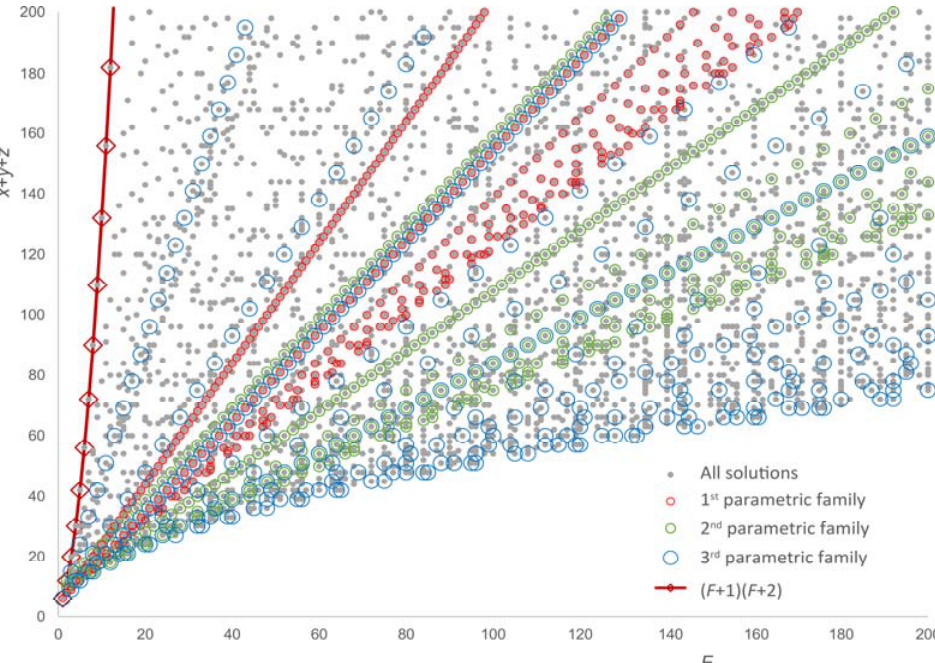
Figure 2. Sum of solution terms of the Diophantine equation xyz = F ( x + y + z ). An upper bound and sums of terms for parametric solutions are indicated by red line and open circles, respectively.